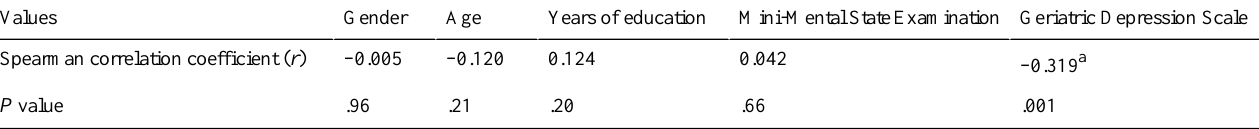
Table 7. Spearman bivariate correlations between User Satisfaction Evaluation Questionnaire scores and demographic, mood, and global cognitive